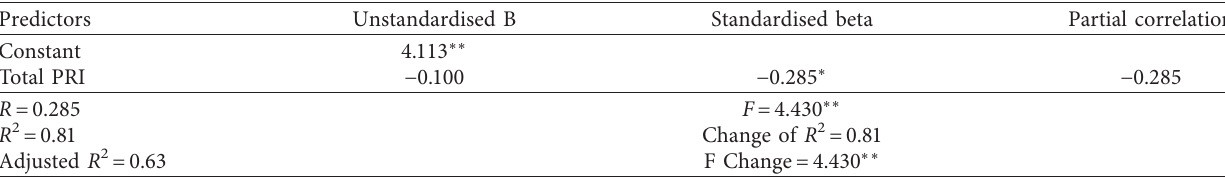
Table 3: Stepwise multiple regression analysis of the scales of the PRI on the mistakes made in the attention test.